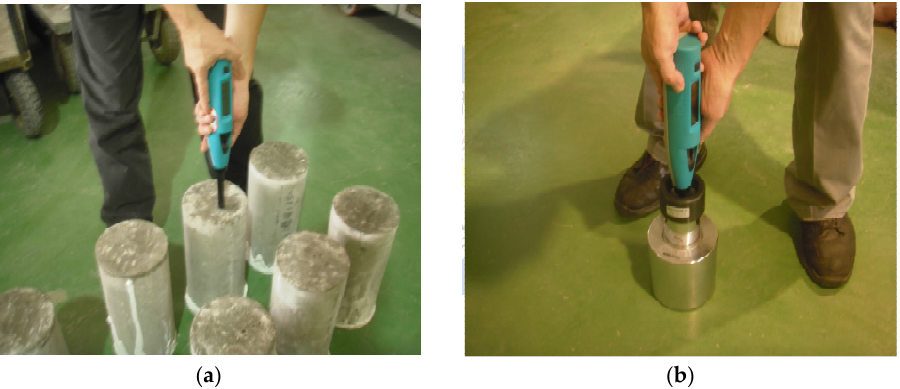
Figure 2. ( a ) Rebound hammer test; ( b ) rebound hammer calibration.